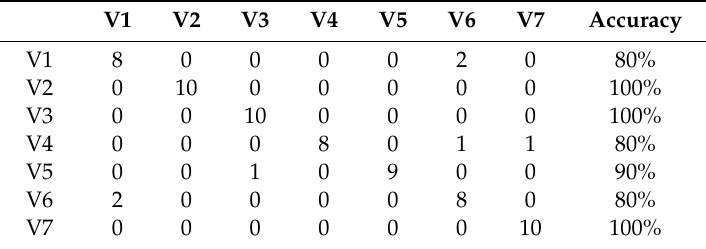
Table 8. Confusion matrix for sweet corn seed classification based on the SDA + LDA model.